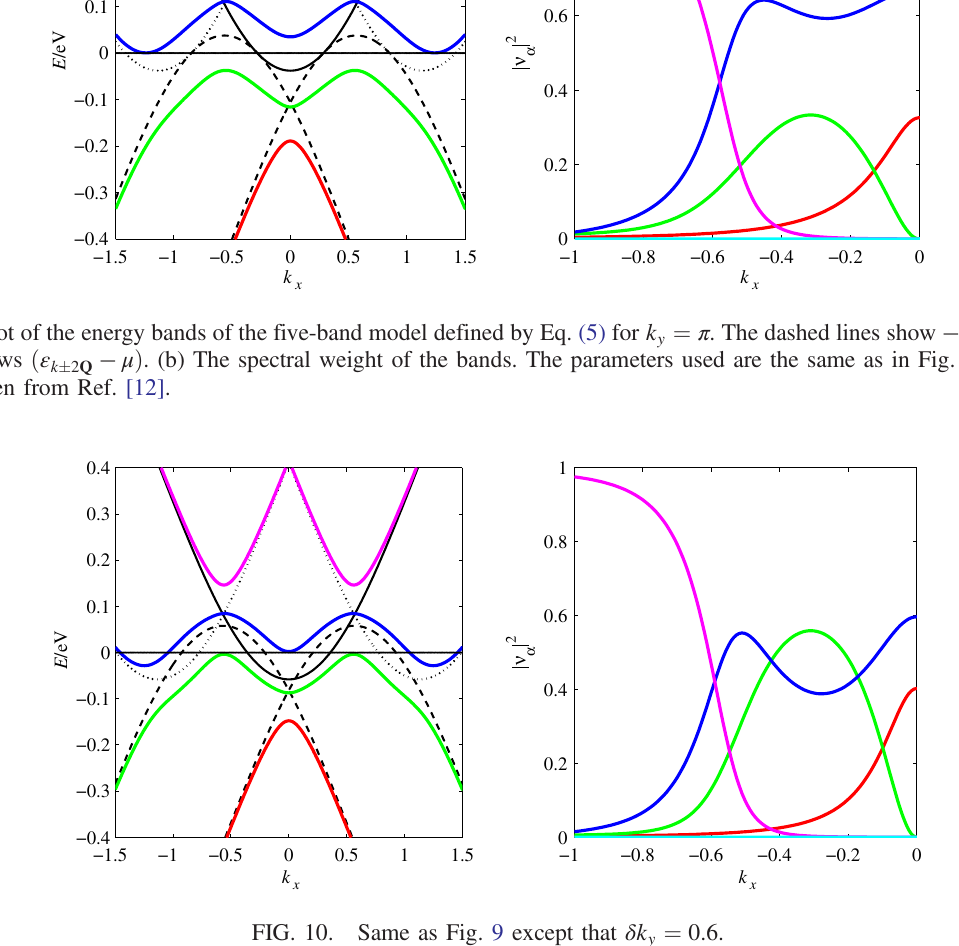
FIG. 10. Same as Fig. 9 except that δ k y ¼ 0 . 6